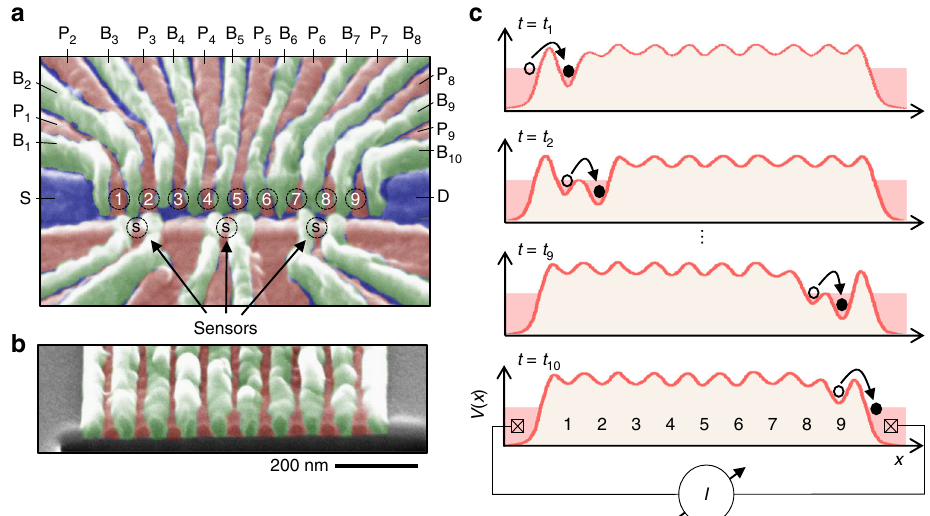
Fig. 1 Si charge shuttle. a False-color SEM image of the device consisting of a 9-dot linear array (dots numbered from left to right) with 3 proximal charge sensors (denoted with a circled ‘ S ’ ). The potentials of the dots are controlled by the plunger gates (pink) while the tunnel barriers are controlled by the barrier gates (green). The source and drain accumulation gate electrodes are shown in blue. b Tilted-angle cross-sectional SEM image of overlapping Al gates fabricated on a Si substrate. A focused ion beam was used to prepare the sample before imaging. c Illustration of the charge shuttling sequence showing the quantum dot con fi nement potential V ( x ) at 4 different times during the shuttling sequence